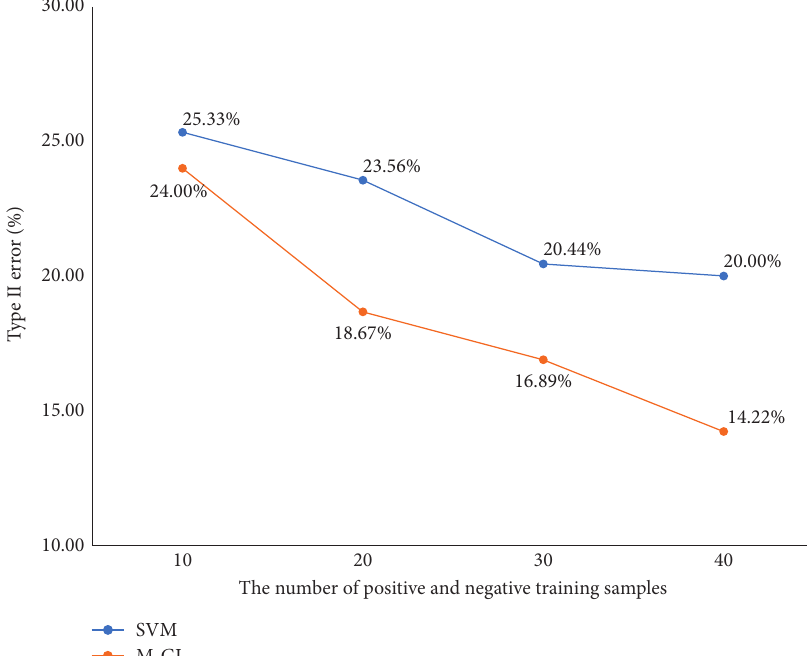
Figure 6: Variations of Type II error with the increased number of labeled samples for